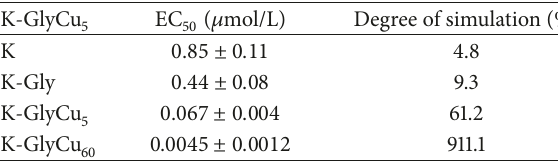
Table 1: EC 50 of FK-Gly and